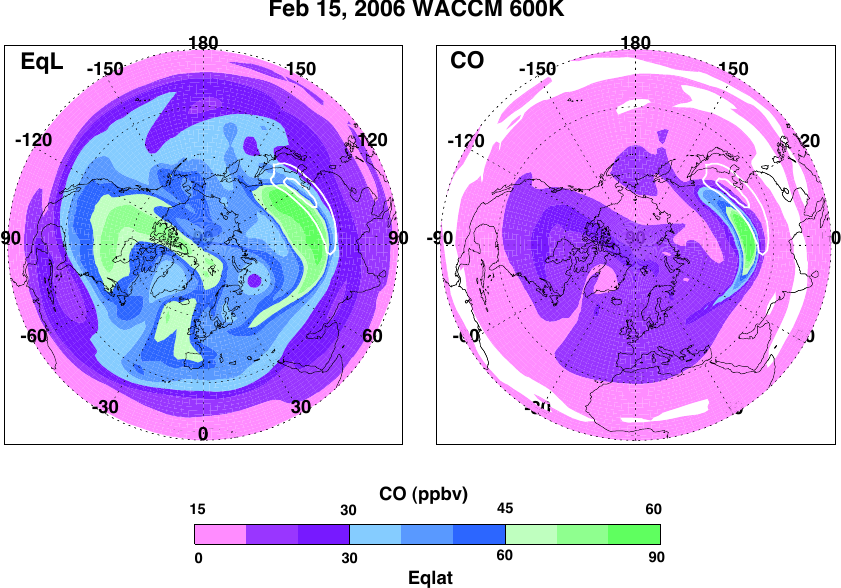
Fig. 3. Distribution of EqLat (left) and CO (right) on the 600K isentropic surface. The white contours represent 30 and 40ms − 1 wind speeds.